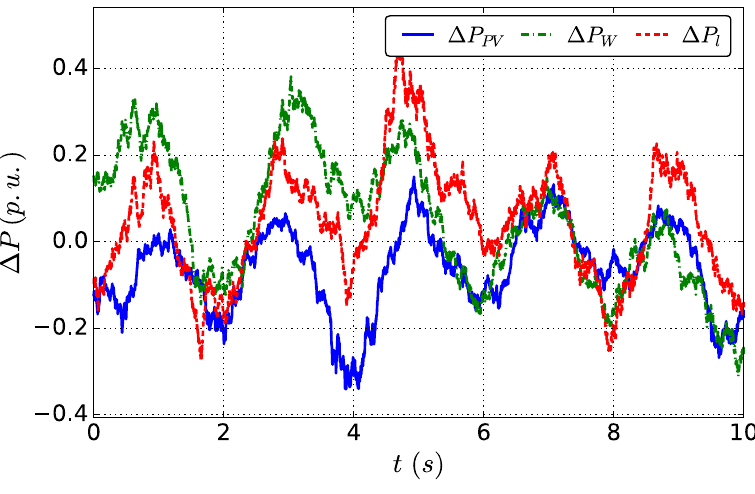
Figure 5. Power deviations of PVs, WTs and loads in MG 1.